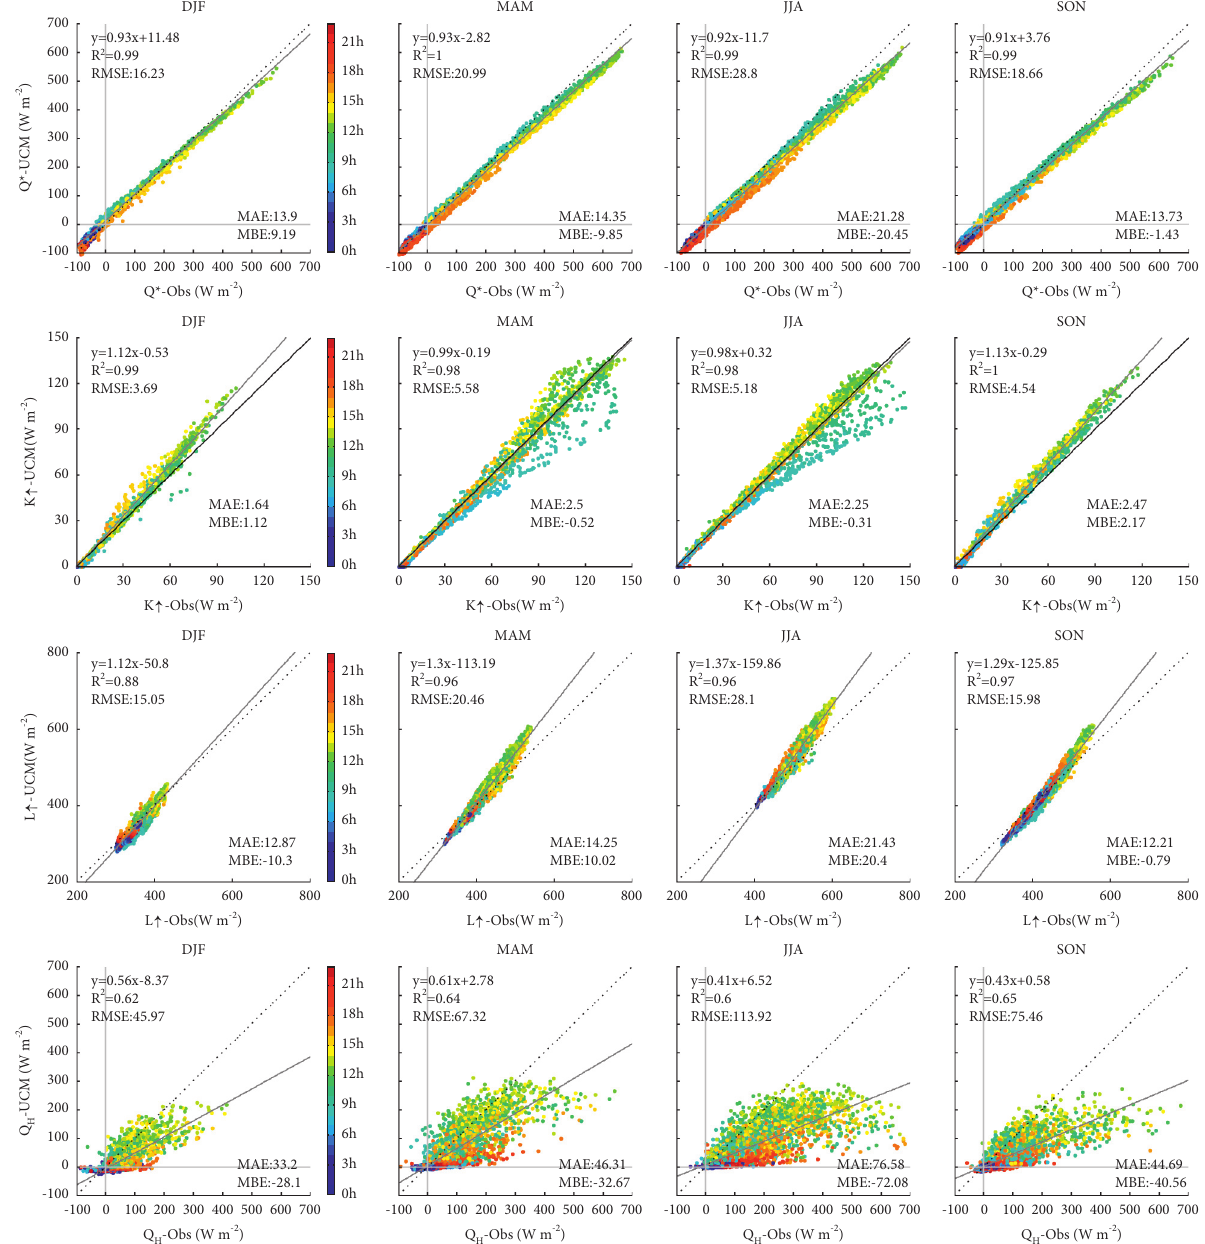
Figure 12: Scatter plots of observed and modeled fluxes after parameter optimization. The dot colors represent the hours, R 2 , RMSE, MAE, and MBE are